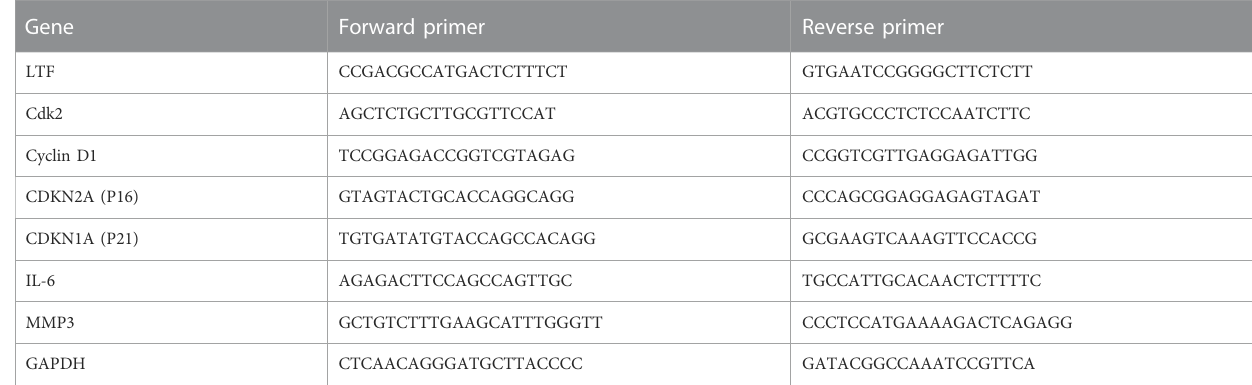
TABLE 1 Primer sequences for